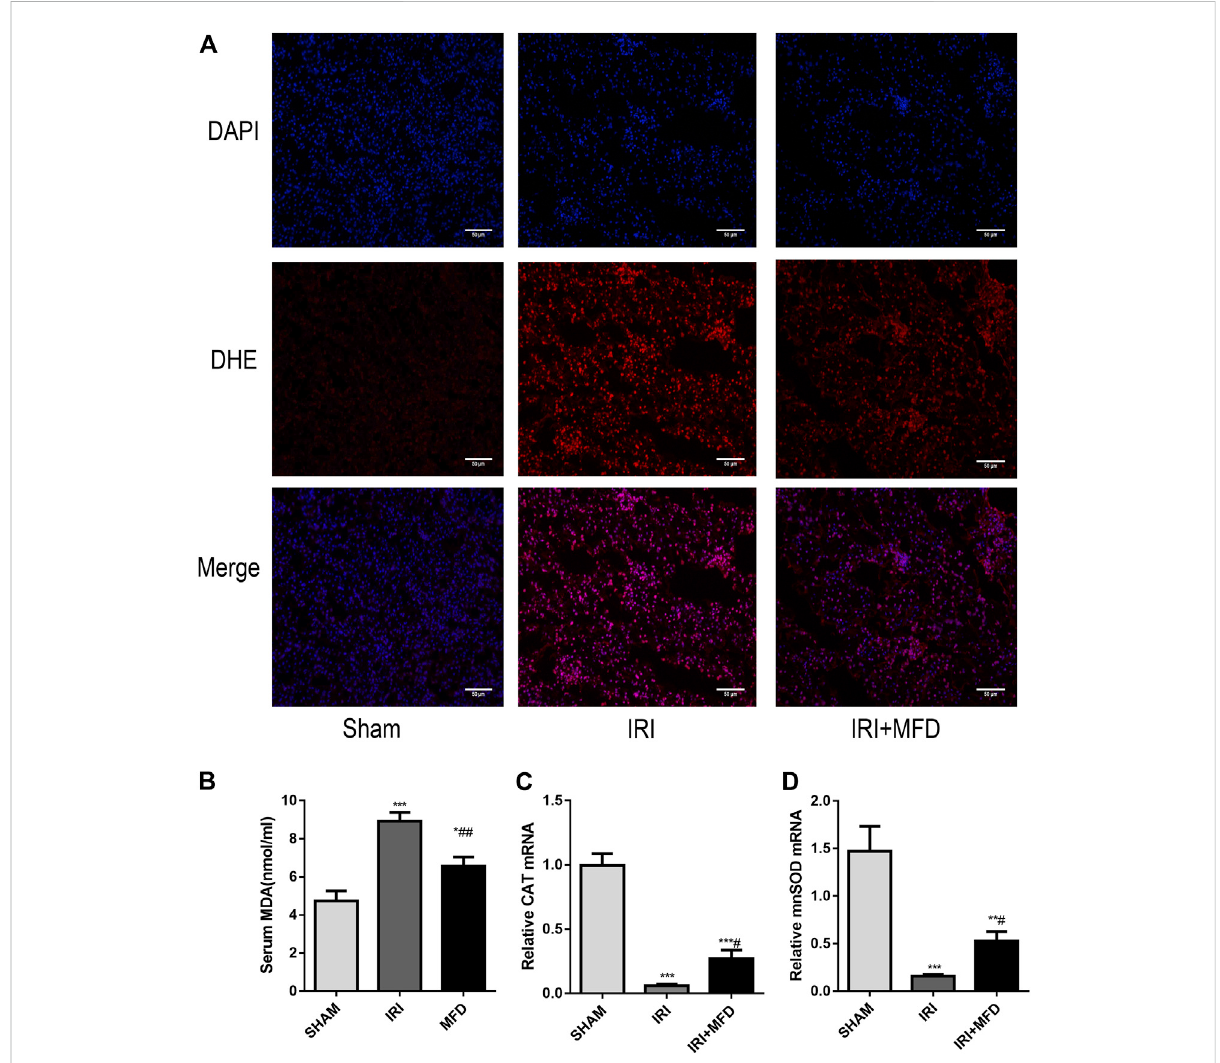
Mefunidone reduced IRI-induced oxidative stress accumulation. (A) DHE immuno fl uorescence staining for ROS detection in the renal tissues onday2after IRImodeling(×200). (B) RenalMDAlevel intherenaltissuesonday2afterIRImodeling. (C)